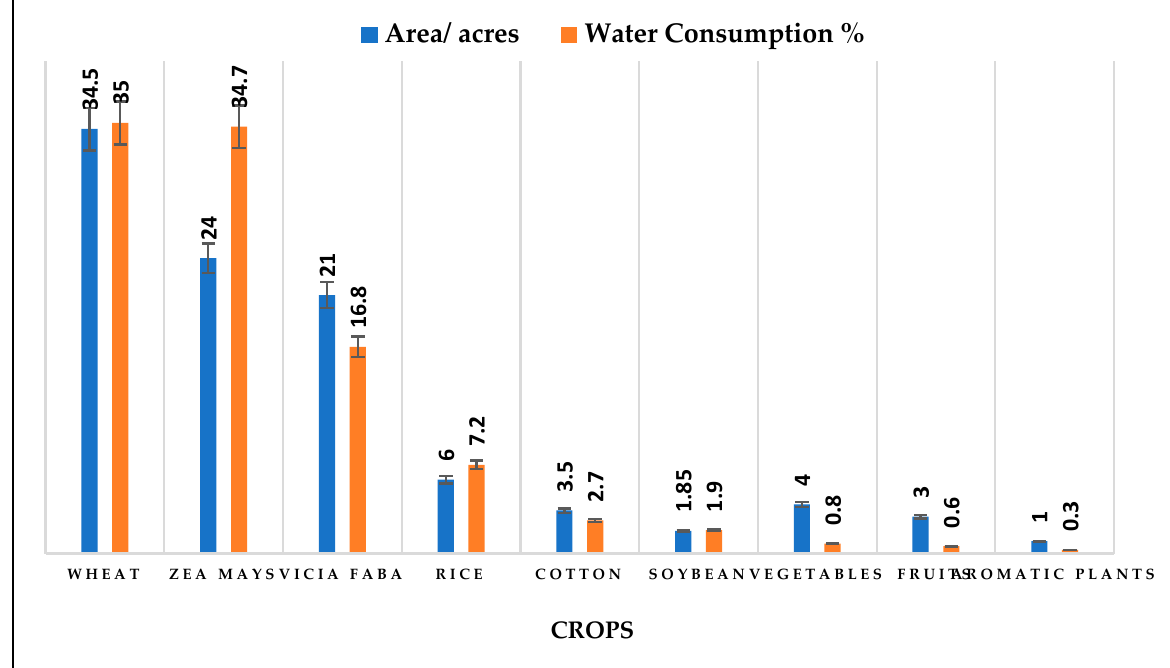
Figure 9. Annual cultivation of plants and its water consumption per capita for WD valley.